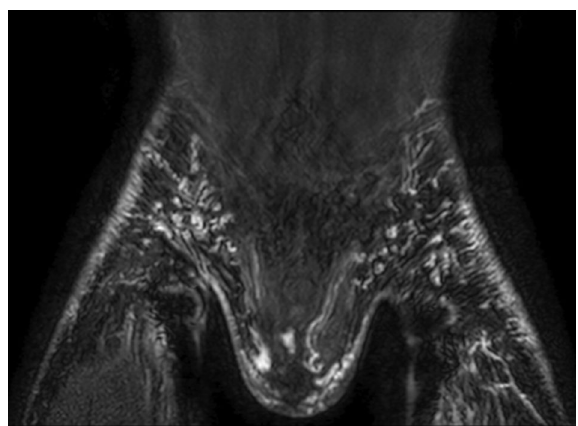
Figure 5. 19-year-old male with peripheral/genital edema and chylothorax. Coronal contrast-enhanced MR-lymphangiogram of the inguinal region showing extensive lymphatic reflux from the inguinal nodal injection sites into superficial lymphatics of both legs, of the abdominal wall as well as into genital